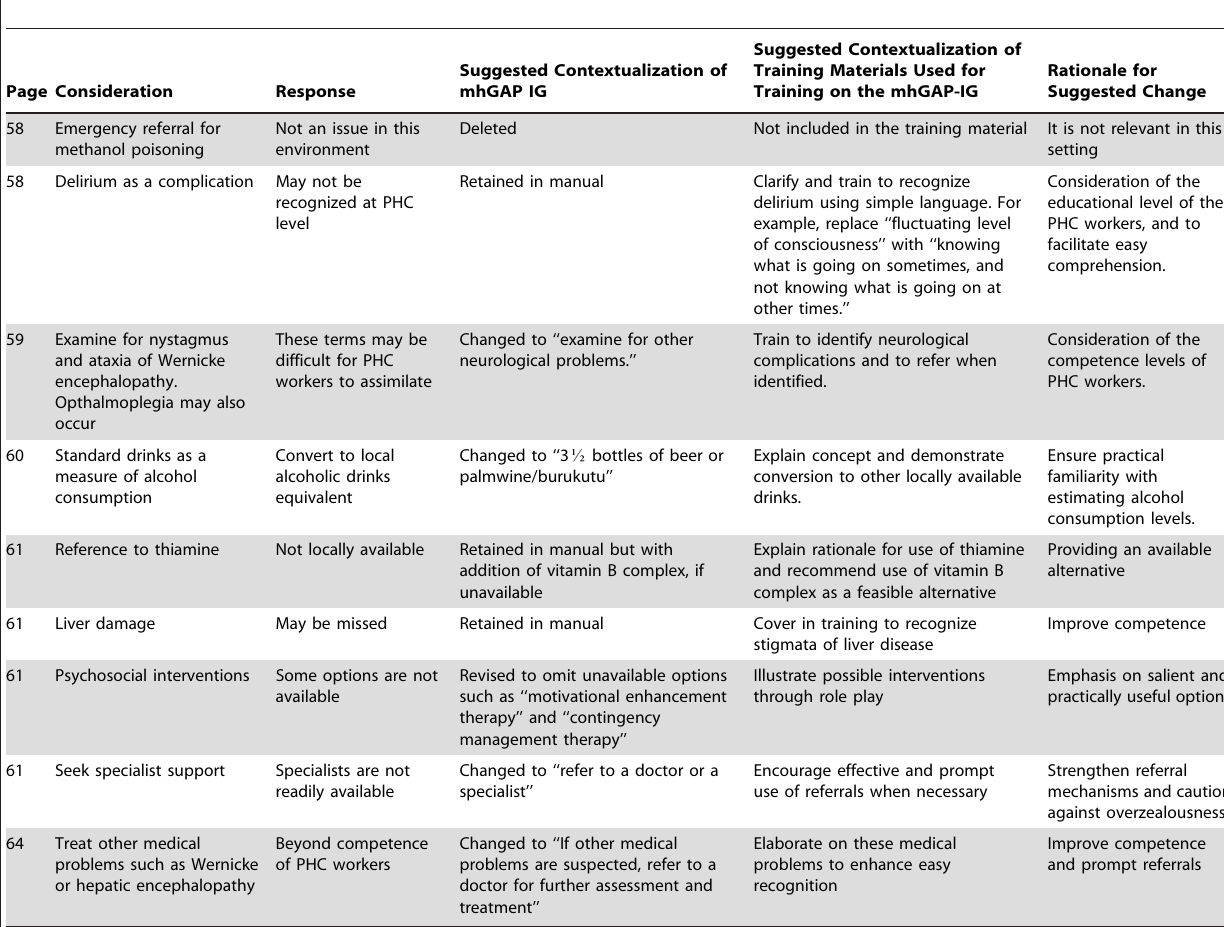
Table 1. Some examples of changes effected in two modules (Alcohol Use, Alcohol Use Disorders, Drug Use, and Drug Use Disorders) of the Mental Health Gap Action Programme – Intervention Guide in contextualizing it for